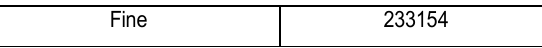
Figure 4. Variation of C m with azimuthal position for three grid resolution.